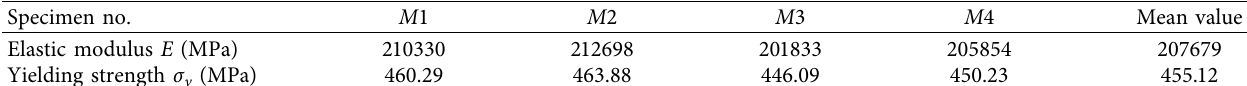
Table 2: Mechanical properties of HRB400 bars.